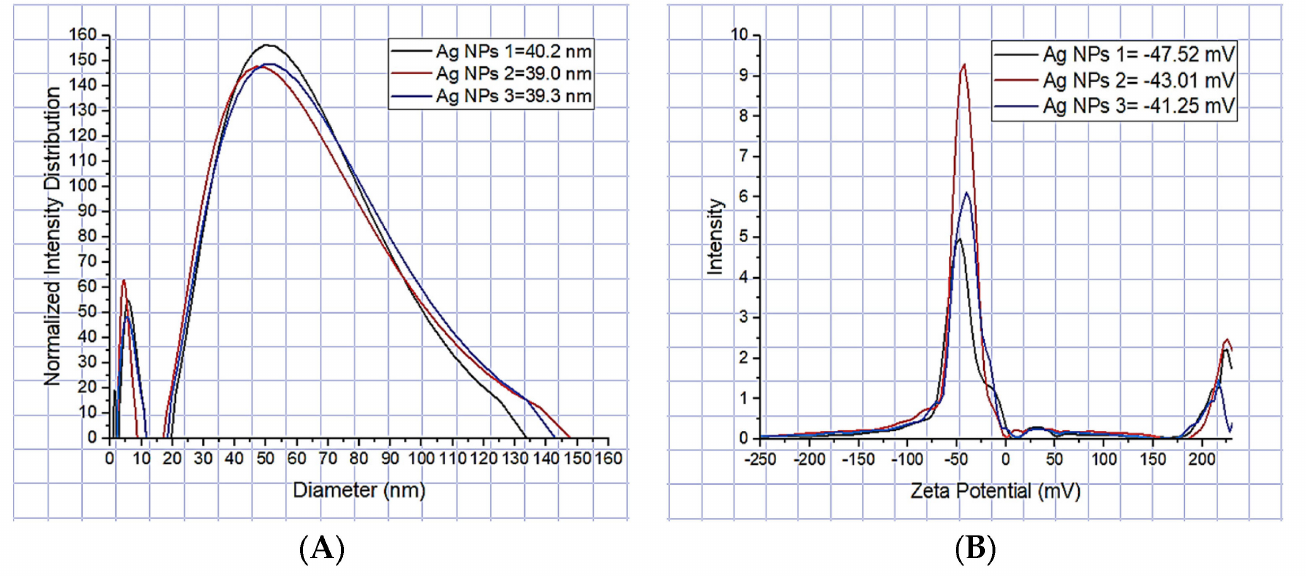
Figure 2. ( A ) Average diameter of Ag-NPs. ( B ) Z-Potential of